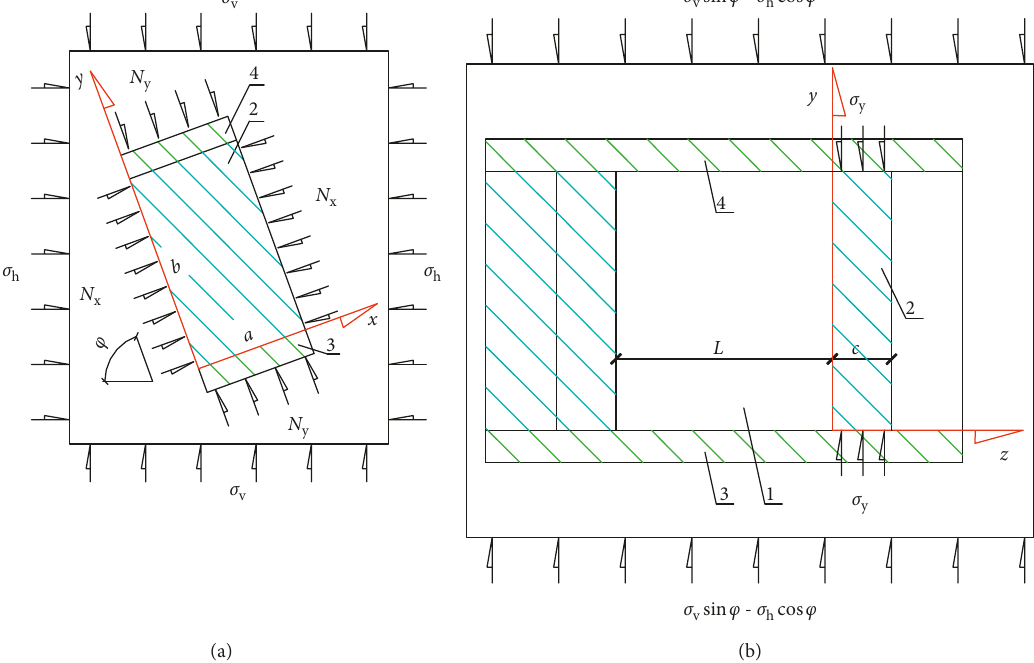
Figure 2: Force diagram of stress analysis of the intervening pillar between stopes on (a) x - y plane and (b) y - z plane. 1, completed stope; 2, intervening pillar; 3, bottom pillar; 4, top